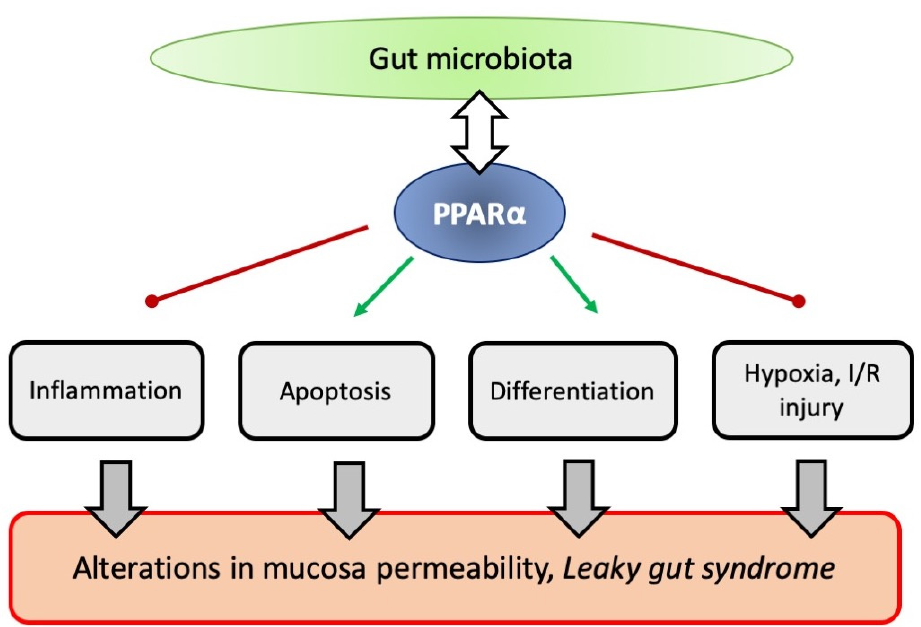
Figure 2. The scheme that summarizes the described impact of PPAR α on various aspects of gut physiology, which may contribute to the development of the “leaky gut syndrome”.